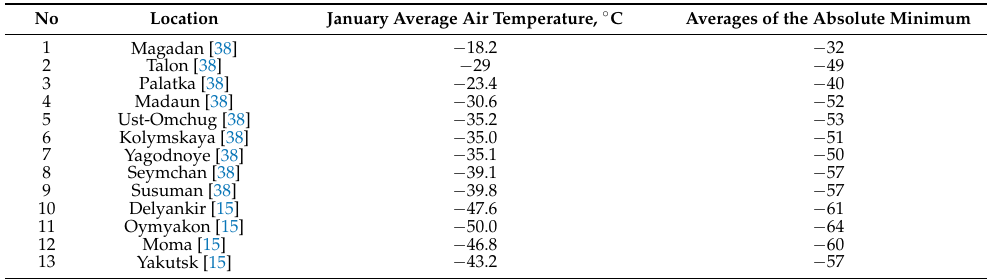
Table 5. Winter temperature gradient ( ◦ C) from the coast of the Sea of Okhotsk to the upper reaches of the basin of the Indigirka River. Location of weather stations illustrated in Figure 4. No Location January Average Air Temperature, ◦